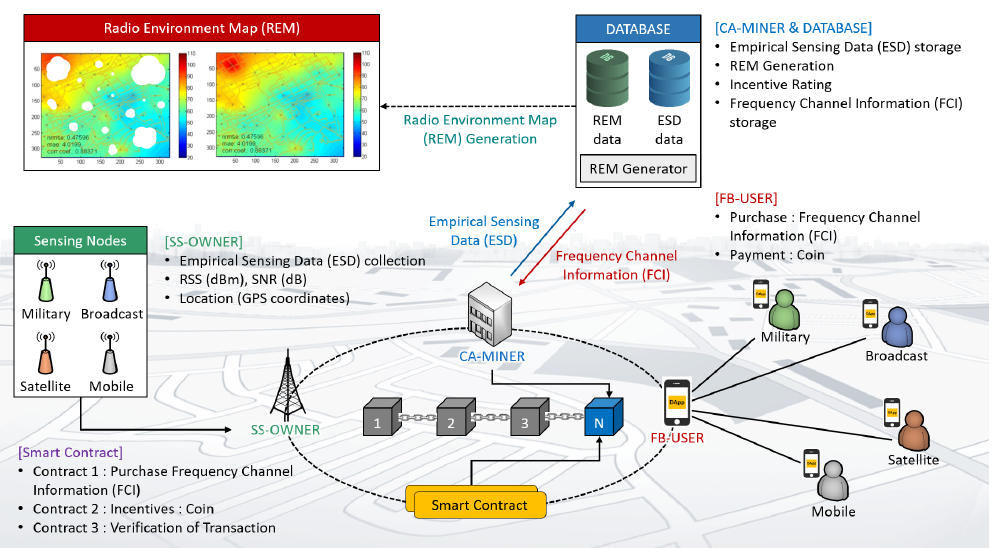
Figure 1. Environmental scenario of the proposed blockchain-based automated frequency coordination system (BAFCS)